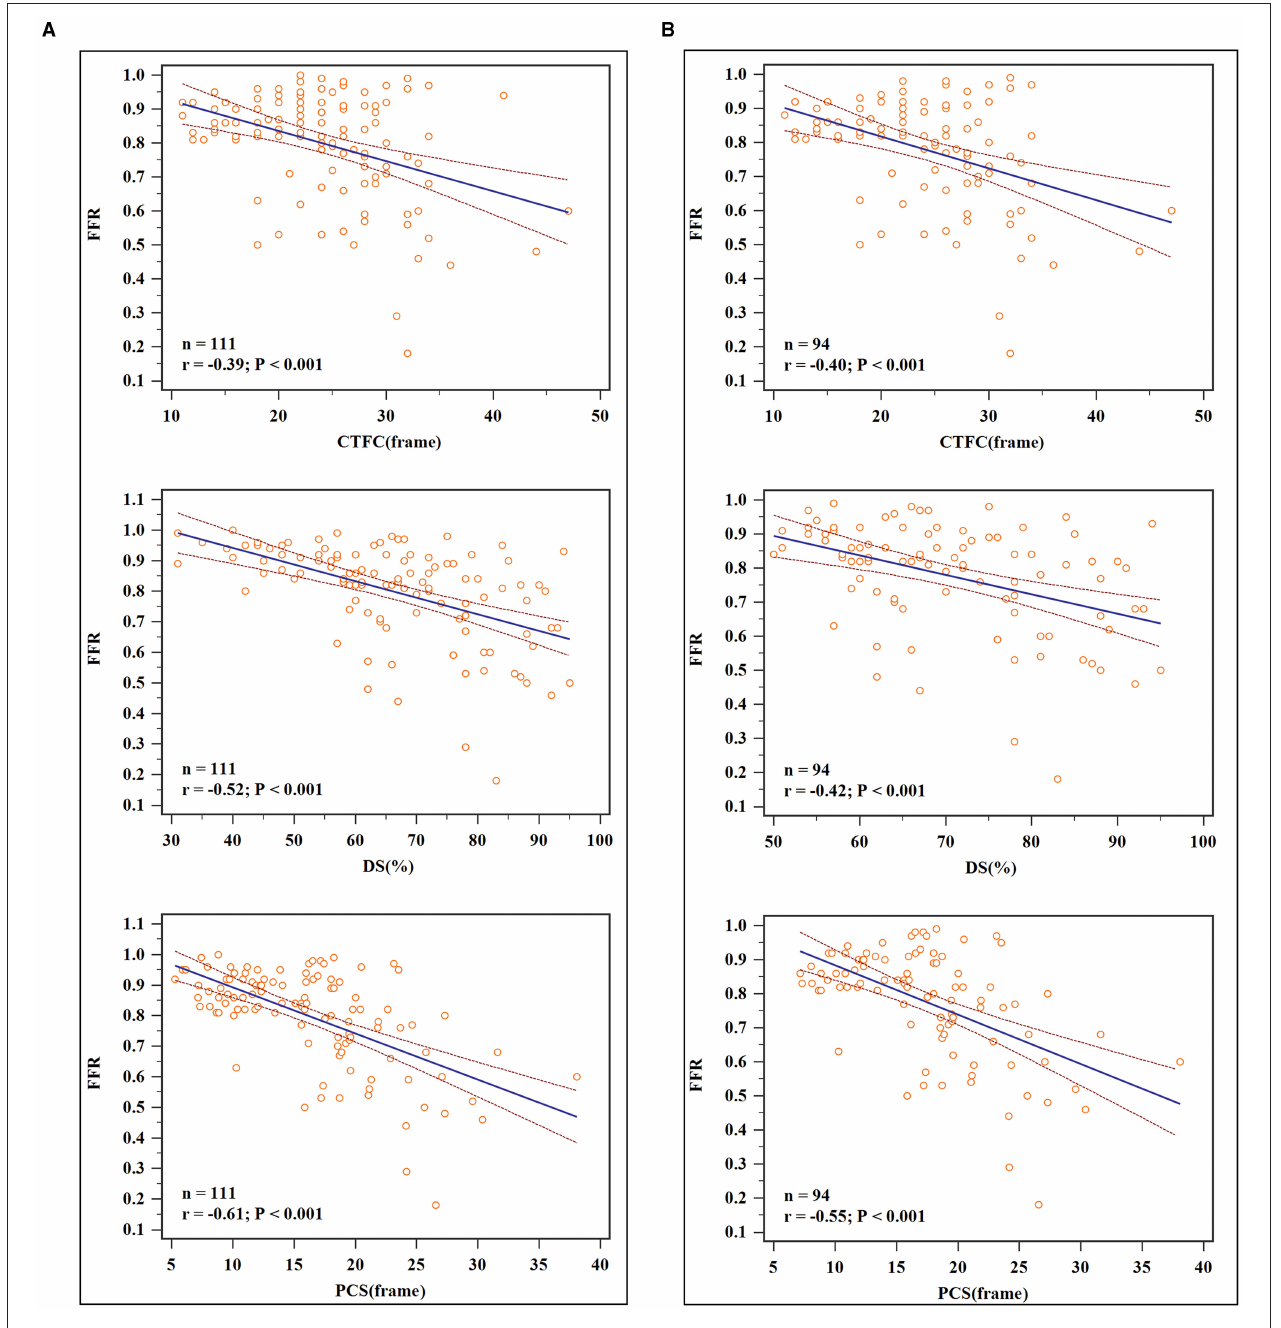
FIGURE 2 | Scatterplots and linear regression results. (A) For all vessels: DS ( r = − 0.52), CTFC ( r = − 0.39) and PCS ( r = − 0.61) were correlated negatively with FFR. (B) For vessels with DS ≥ 50%: DS ( r = − 0.42), CTFC ( r = 0.40), and PCS ( r = − 0.55) correlated weakly yet statistically significant with FFR.